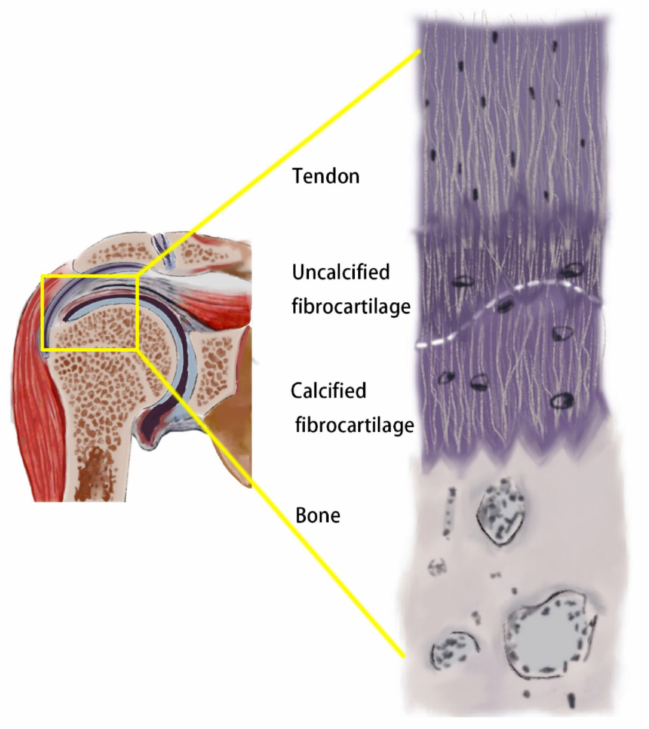
Figure 1. Four zones at the